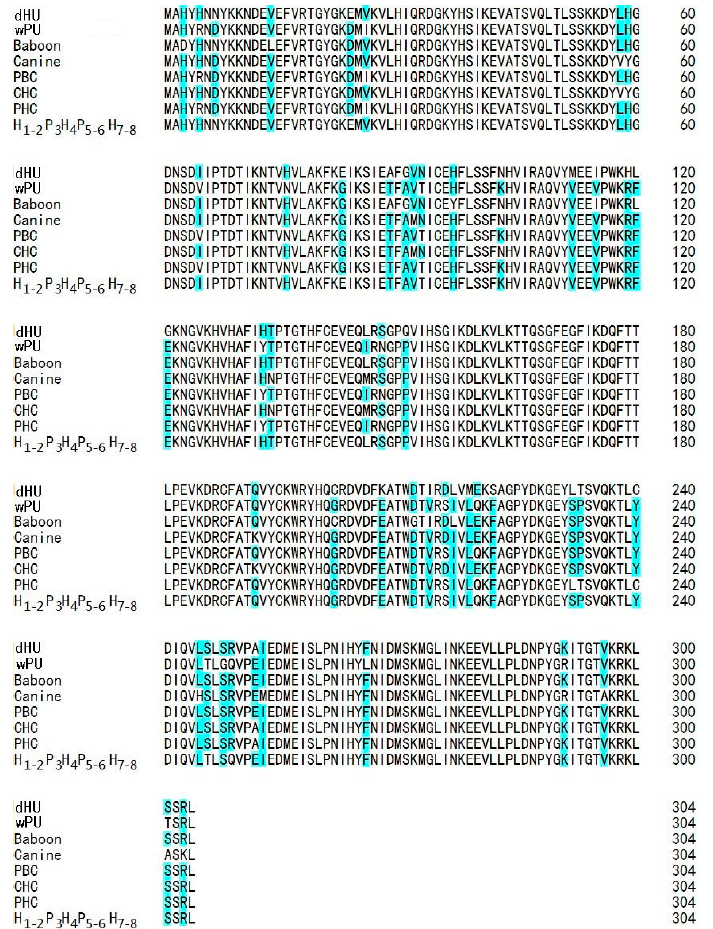
Figure 3. Alignment of deduced protein sequences of H 1-2 P 3 H 4 P 5-6 H 7-8 with nonfunctional dHU and six functional Uox. Protein sequences are given as standard single-letter designations. DNA sequences of dHU (AB074326.2 with correction of the two stop codons), baboon uricase (BAB91554.1), canine uricase (NP_001069116.1), and porcine uricase (NP_999435.1) are retrieved from GenBank. DNA sequences of pthe orcine–baboon chimera (PBC), porcine–human chimera (PHC), and canine–human chimera (CHC) were obtained from related patents. Inconsistent amino acid residues are highlighted with light blue.